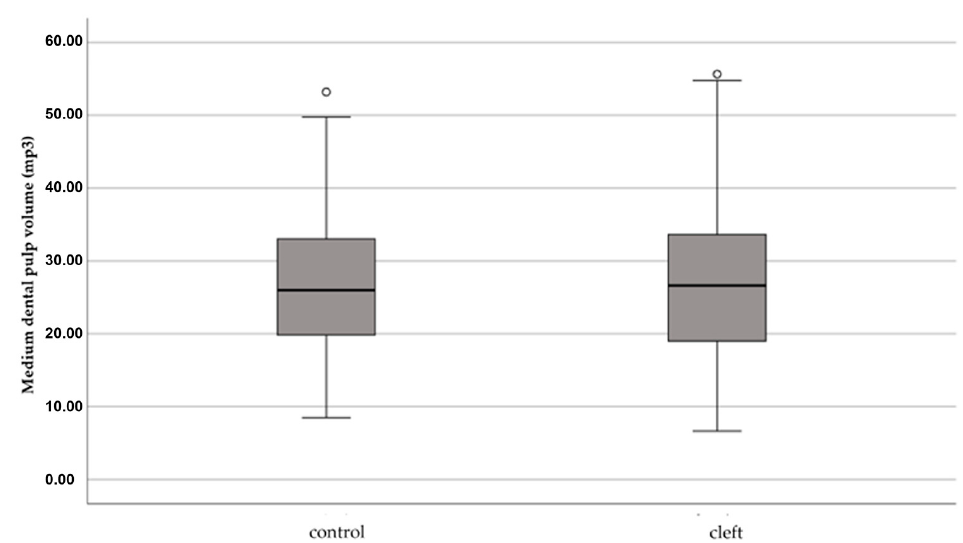
Figure 2. Diagram of extremes and quartiles shows the value distribution of the medium pulpal volume for both the control and CLP groups.